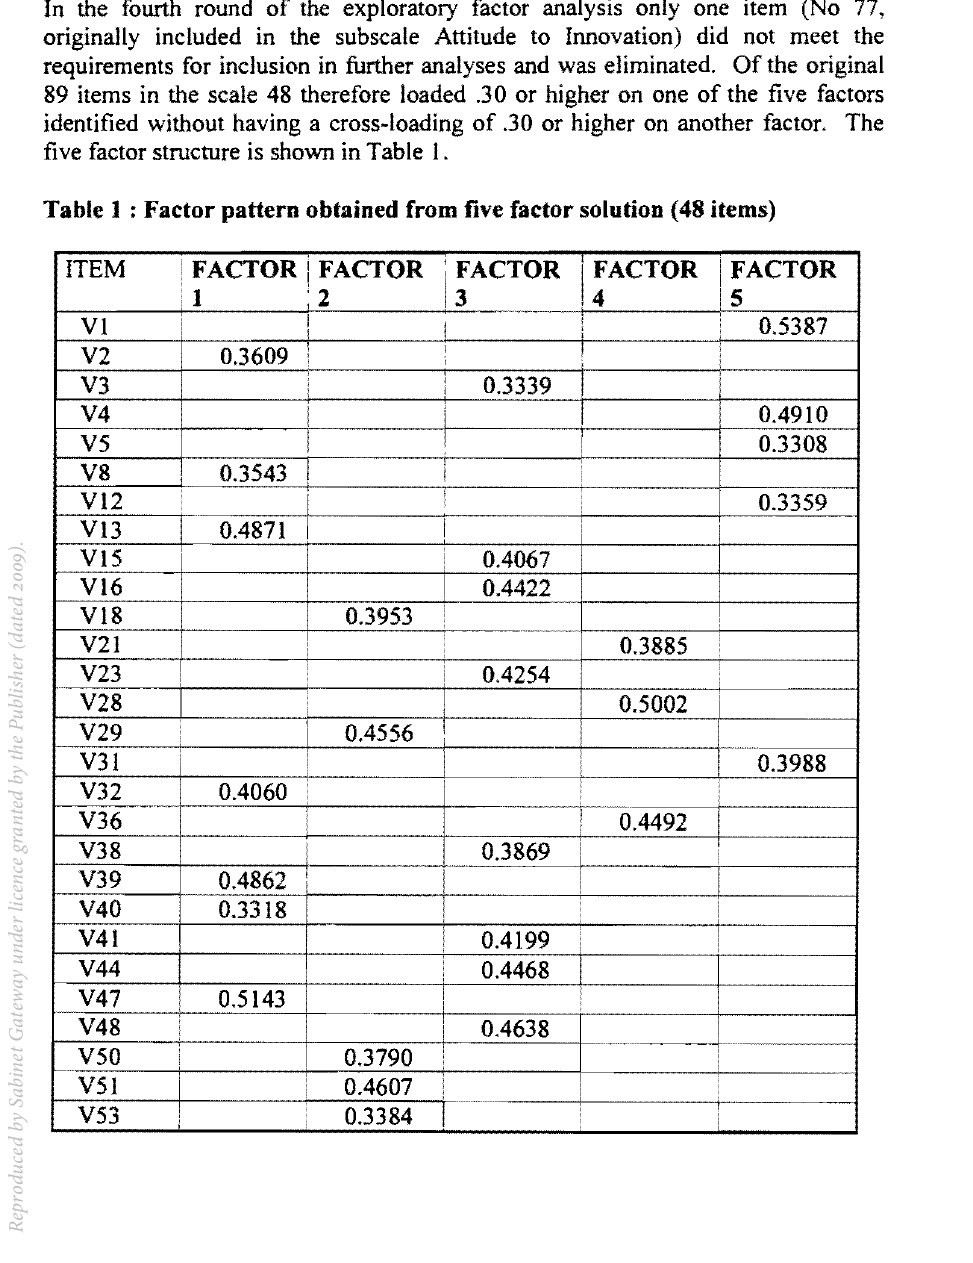
Table I : Factor pattern obtained from five factor solution (48